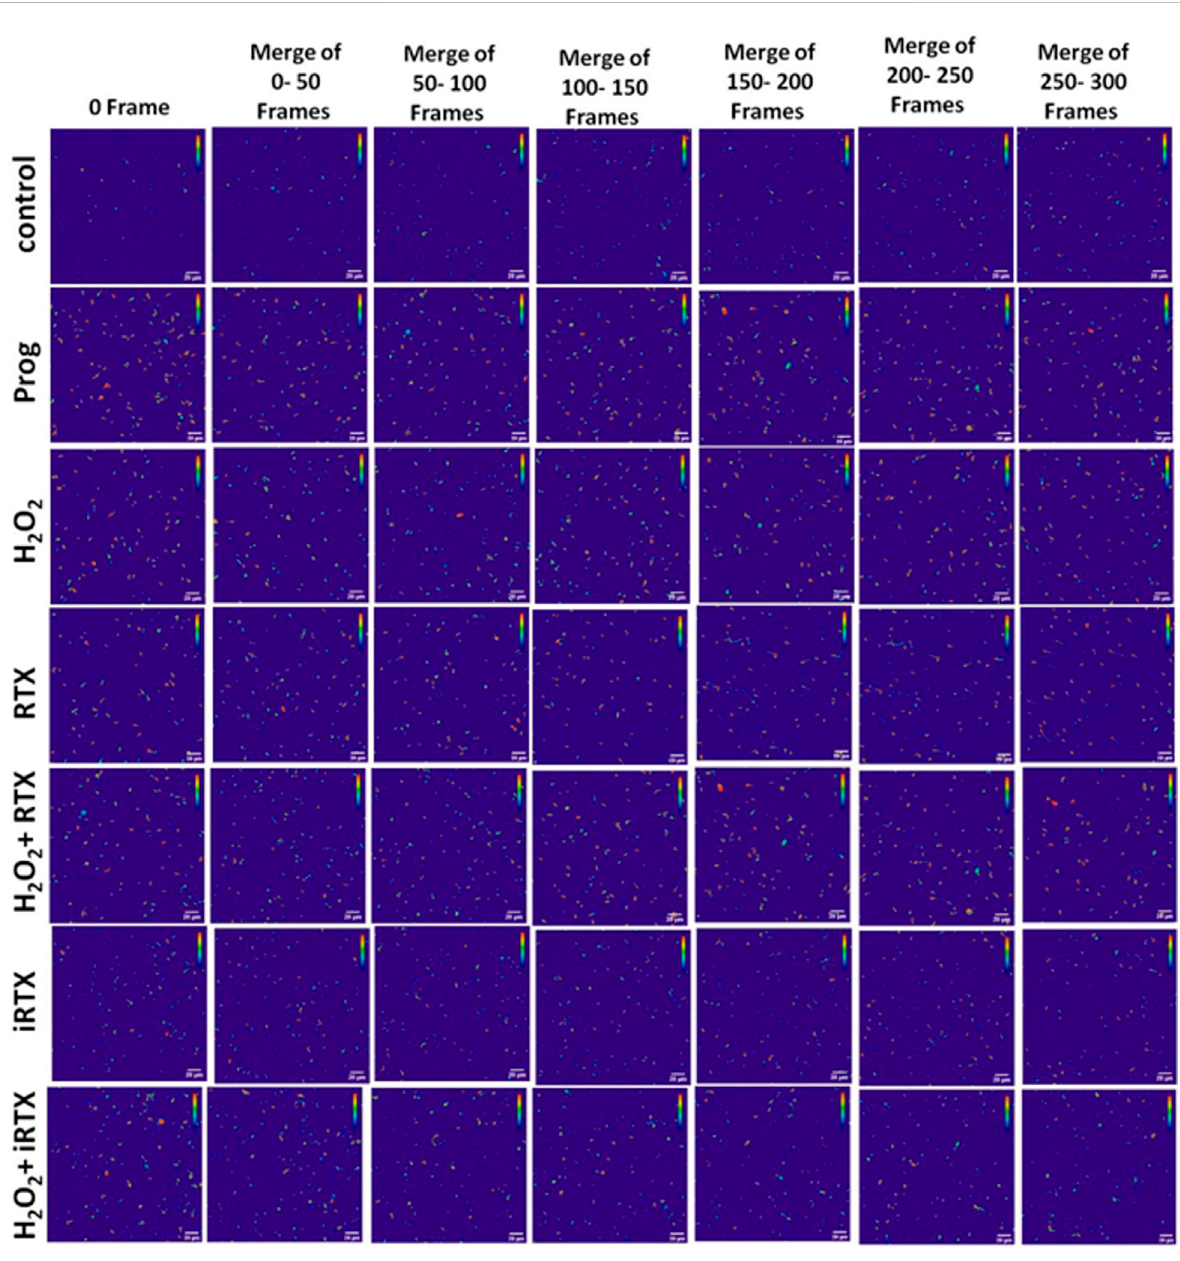
Time series images of Ca 2+ -intensity in live sperm cells. Cells were loaded with Fluo-4-AM and fl uorescence intensity is represented in pseudo color (red and blue indicating highest and lowest intensity, respectively). Calcium imaging was performed at the speed of 2 frames per